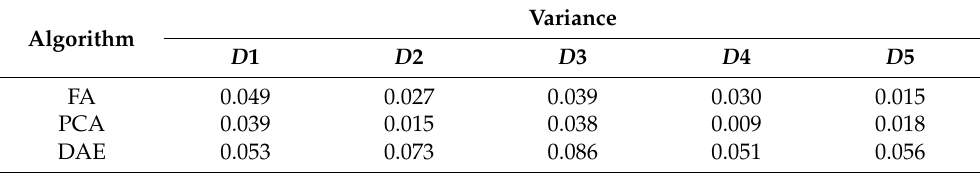
Table 4. The variance of the coding sequence of stock data after dimensionality reduction.